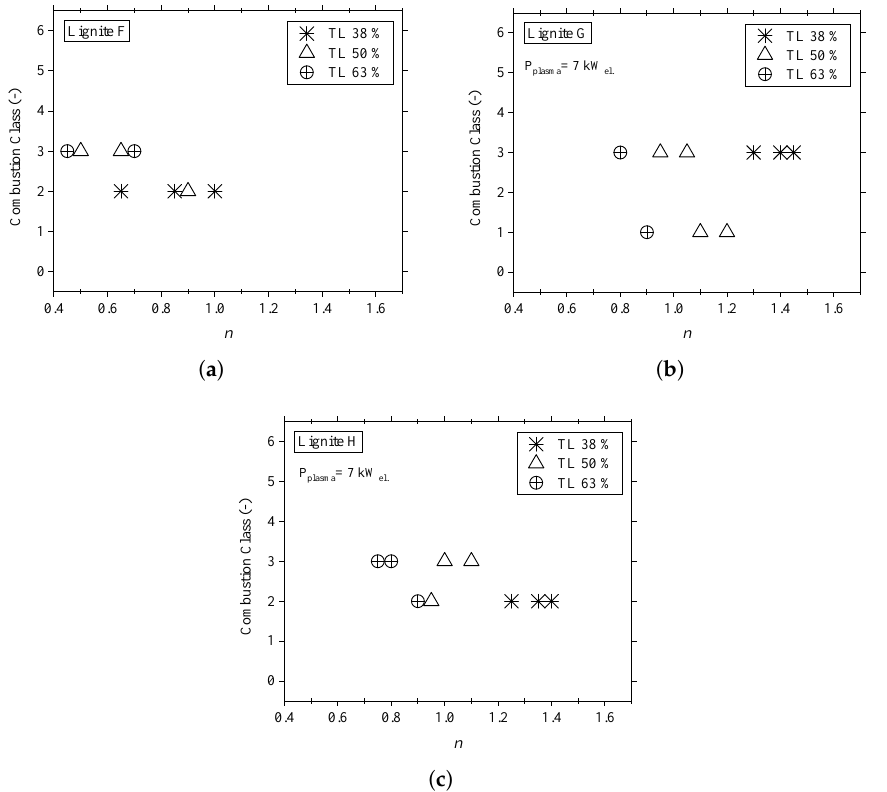
Figure 4. The Combustion Class versus air ratio obtained by three lignite qualities at several thermal loads (TL), ( a ) Lignite F, ( b ) Lignite G, ( c ) Lignite H, Lignite G and Lignite H are ignited with a 7 kW plasma